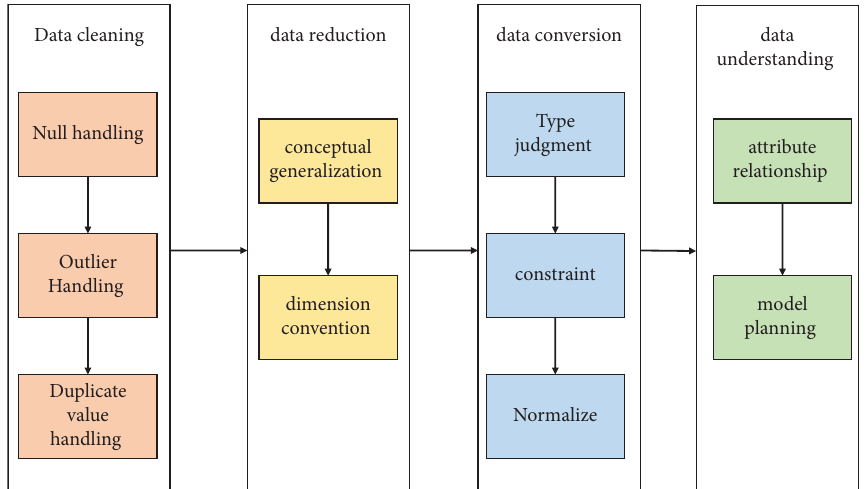
Figure 1: Data preprocessing fow